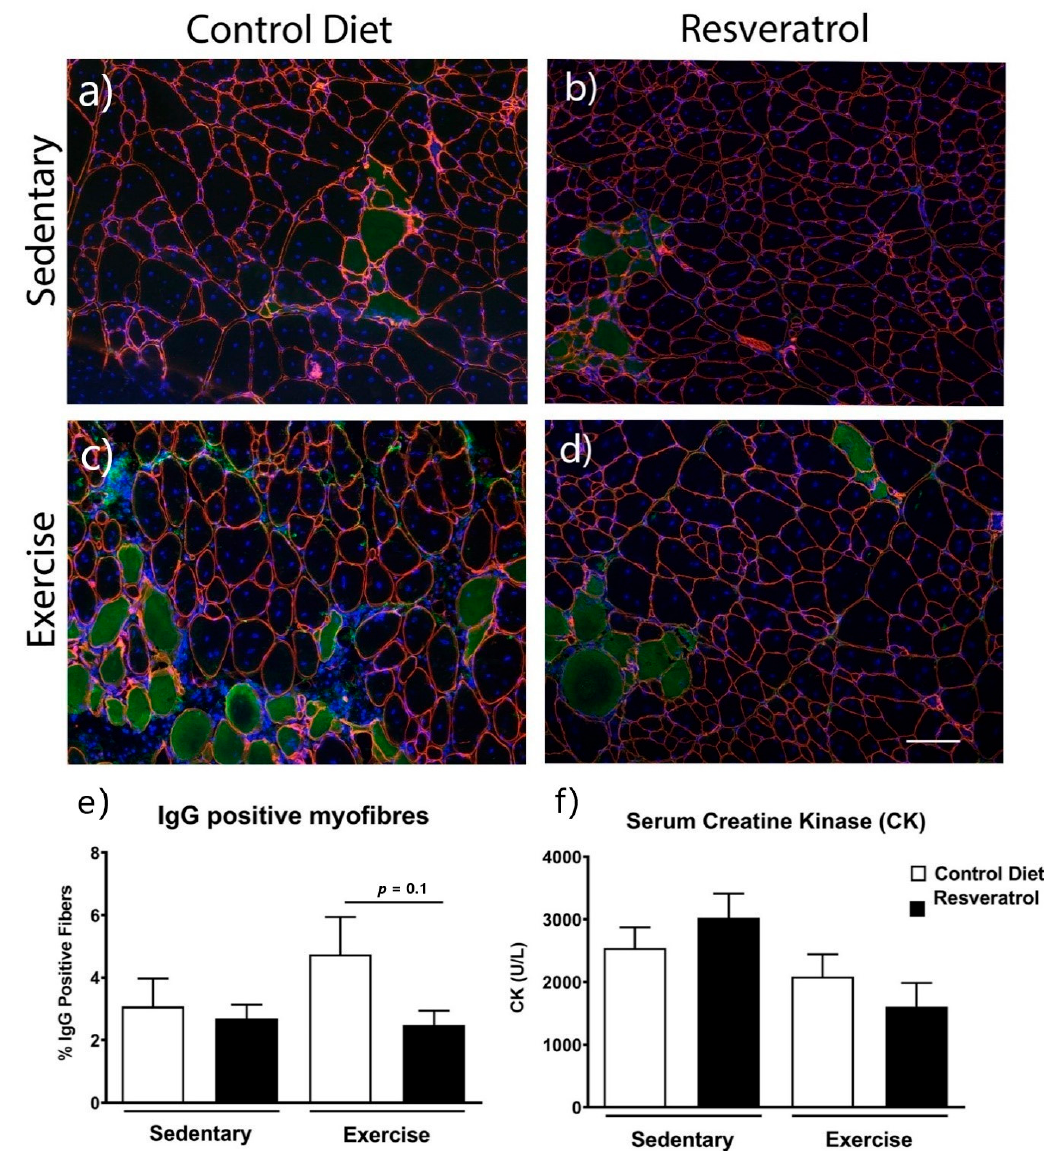
Figure 4. Quadriceps muscles were stained with laminin α 2 (red), nuclei with Hoechst (blue) and IgG (green) which enters fibres with impaired sarcolemma. Representative image of ( a ) an mdx control diet sedentary quadriceps, ( c ) a control diet exercise mdx quadriceps, ( b ) a resveratrol treated sedentary mdx quadriceps and a ( d ) resveratrol treated exercise mdx quadriceps. ( e ) Quantitative assessment of the quadriceps muscle shows the percentage of damaged IgG positive fibres is unchanged with resveratrol treatment in both exercise and sedentary groups. ( f ) Serum CK activity was similar in all cohorts. The white scale bars represent 200 µ m. Graphs show mean ± SEM. n = 5 for each treatment group.